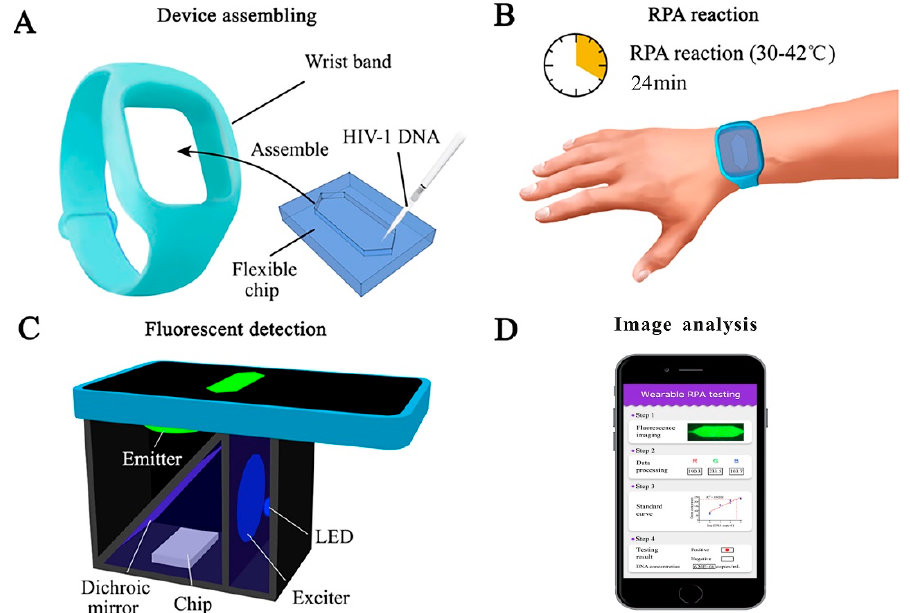
Figure 2. Schematic of a wearable RPA device for HIV diagnosis. ( A ) A wearable and flexible chip made of PDMS. ( B ) RPA reagents and HIV-1 DNA assembled in the wristband and processed by human body heat. ( C ) A cellphone-based fluorescence detection system used to record the amplification results. ( D ) Image analysis conducted through ImageJ to quantify the fluorescent signals. Reprinted with permission from ref. [79]. Copyright 2022, Elsevier.